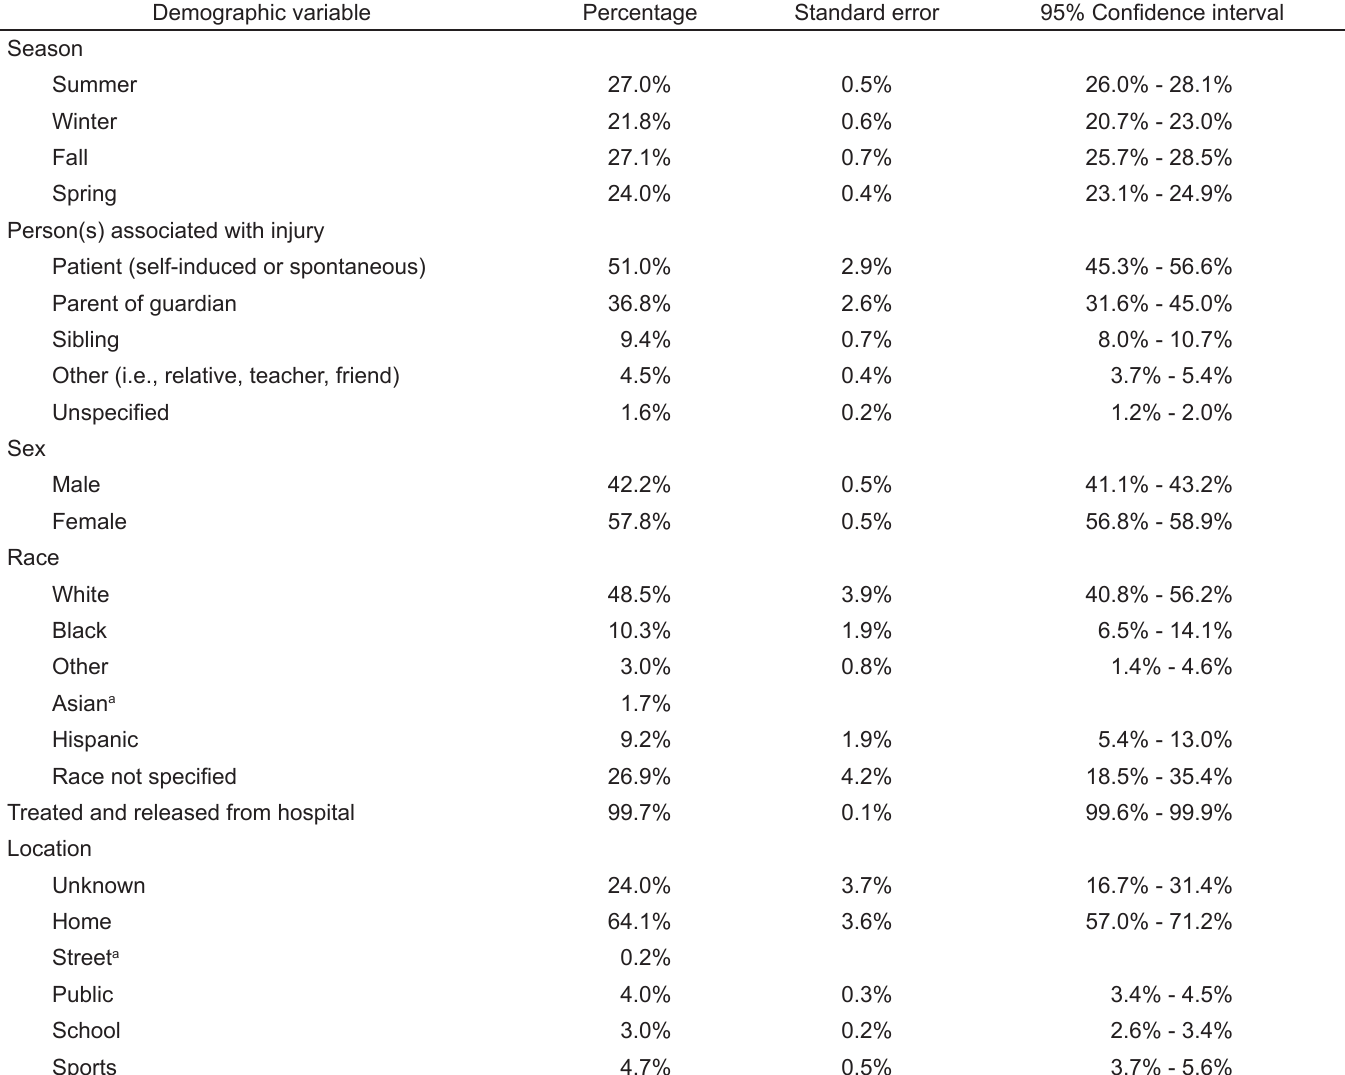
Table 2. Overall demographic characteristics of pediatric patients presenting to U.S. emergency departments with subluxations of the radial head,